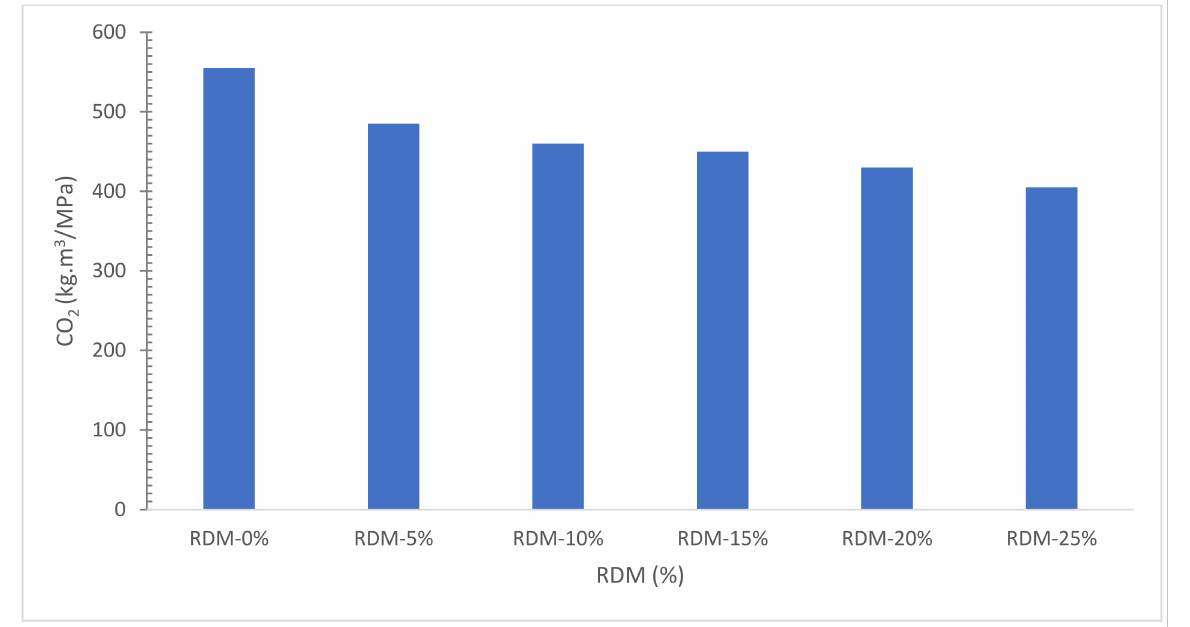
Figure 21. GWP during Concrete Production: Data Source [40].